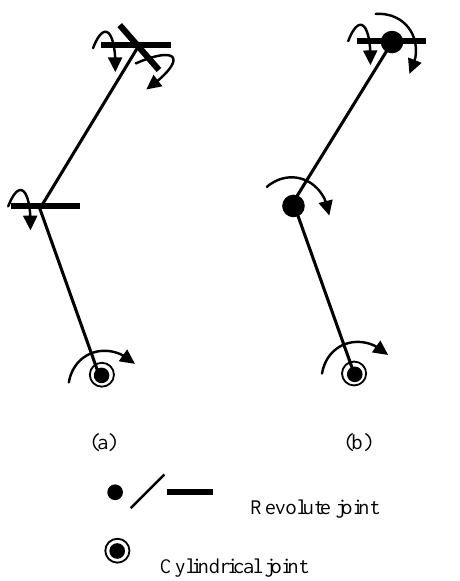
Figure 3. Different joint arrangement of a CRU limb. (a) Joint ar- rangement of the CRU limb of an existing 3-CRU spherical wrist.